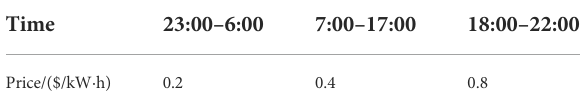
TABLE 3 Time-of-use price.